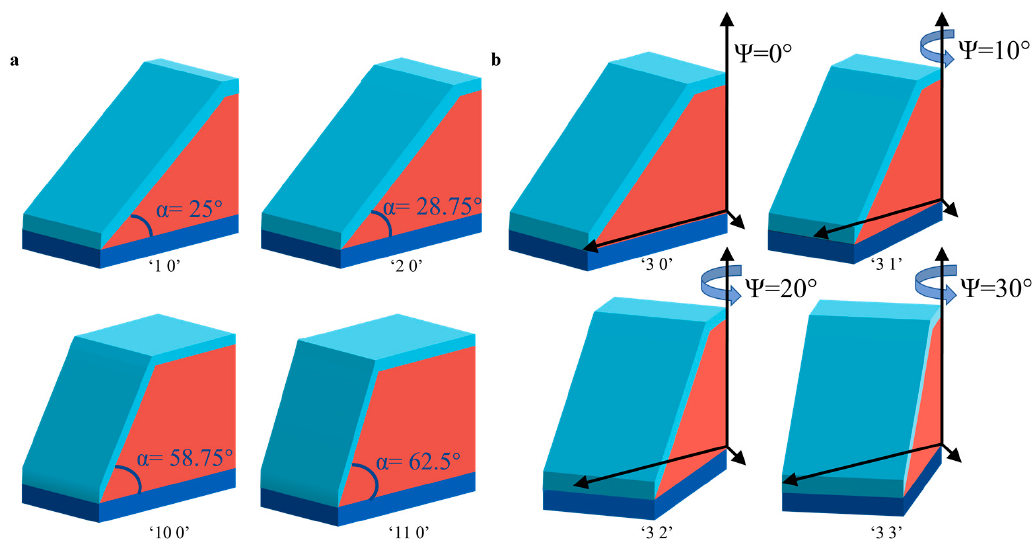
Figure 2. Description of the encoding method: The “ α ψ ” encoding form is used, with α indicating the slope angle and ψ indicating the azimuth of the overall structure; “1 0” indicates data information encoded for a structure with a slope angle of 25 ◦ and an azimuth of 0 ◦ . ( a ) for each 3.75 ◦ increase in slope angle, α increases by one; ( b ) for each 10 ◦ increase in azimuth angle, ψ increases by one.